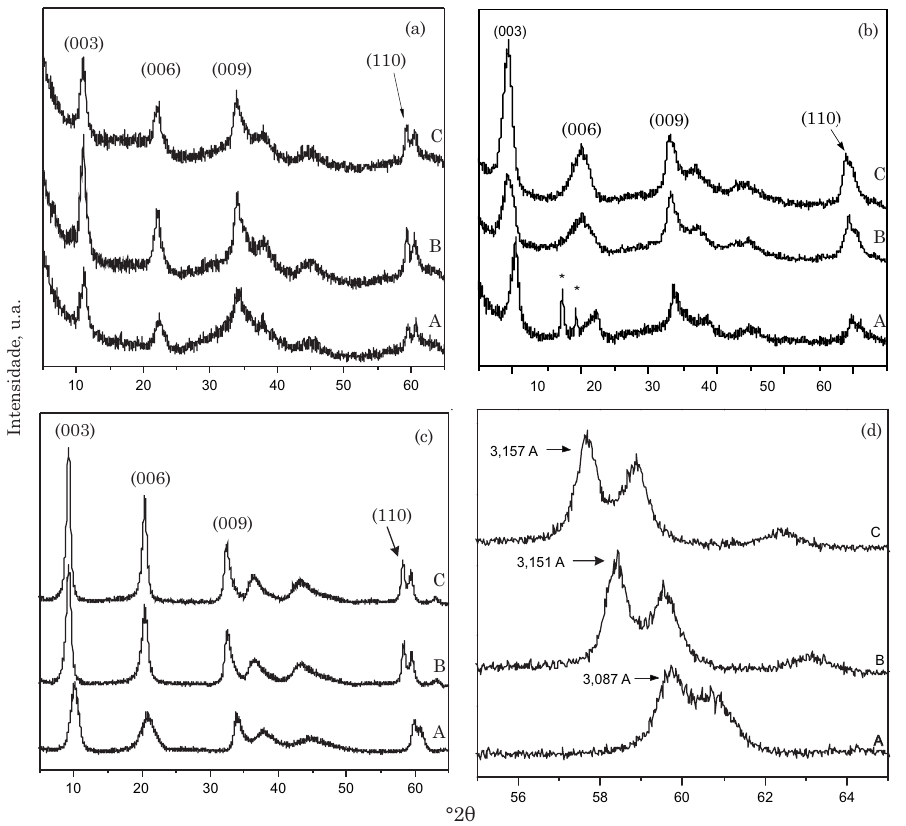
Figura 1. Difratogramas de raios-X dos compostos de hidróxido duplo lamelar (HDL): (a) - HDL-Mg 3 Fe 1 (A), HDL-Mg 4 Fe 1 (B) e HDL-Mg 5 Fe 1 (C), obtidos no pH 9,5; (b) - HDL-Mg 2 Al 0,5 Fe 0,5 , obtido em pH 8 (A), 9 (B) e 10 (C); (c) - HDL-Mg 3 Al 1 (A), HDL-Mg 4 Al 1 (B) e HDL-Mg 5 Al 1 (C), obtidos no pH 10; e (d) - difratogramas expandidos do